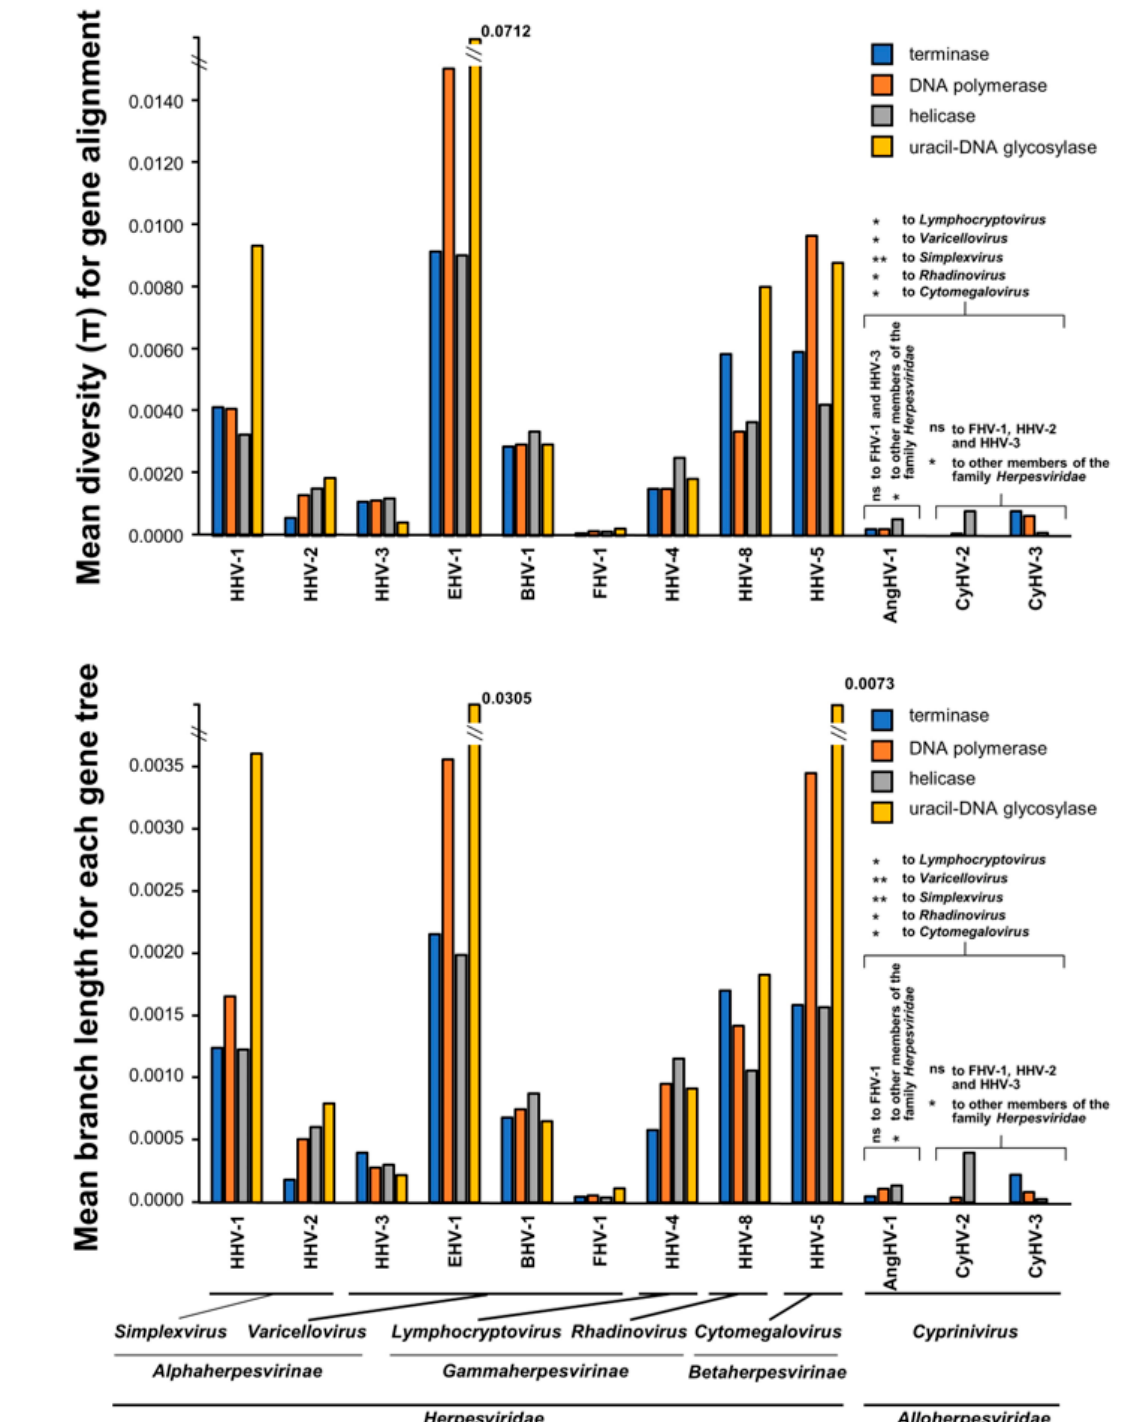
Figure 7. Comparison of nucleotide diversity in core genes between cypriniviruses and members of the family Herpesviridae . Comparisons were based on species-level nucleotide alignments and trees generated using DNA polymerase, helicase, and terminase sequences from each species. Sequences from a fourth core gene, uracil-DNA glycosylase, were also added, facilitating the comparison of diversity between highly conserved and less well conserved core genes. All species name acronyms are defined in Table S1. The comparison consisted of 492 sequences from 123 sequenced strains. The 48 phylogenetic trees corresponding to each species-level gene alignment are provided in Figures S4 and S5. ( a ) Diversity ( π ) from each species-level nucleotide sequence alignment. ( b ) Mean branch length for each species-level tree. Pairwise comparison: * = p < 0.05, ** = p < 0.01.